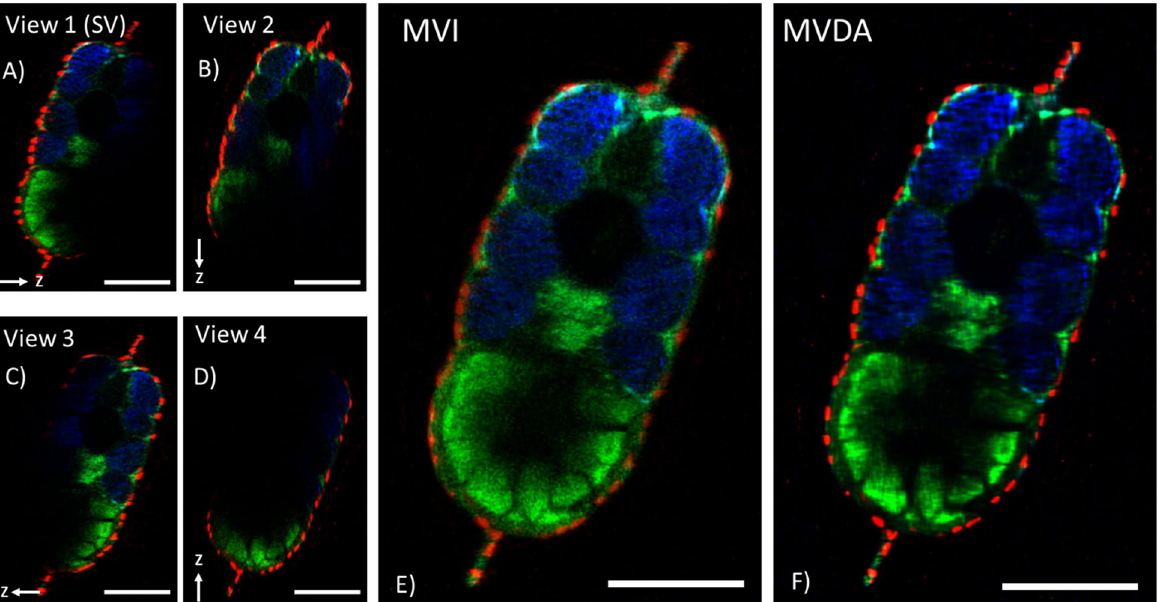
Figure 3. Cross section of the four view Multiview images of a 3dpf zebrafish sample. ( A – D ) Registered individual single view images. Arrow indicates the direction of the z axis of each view. Rotation axis for MVI was on the x-axis which is perpendicular to these images. ( E ) MVI (fusion) of single images, where the entirety of the sample is visible. ( F ) MV deconvolution approximation (MVDA) image. Structures appear with better contrast as noise is decreased and resolution improved. Low signal features become better visible in this image. Scale bars 100 μm. (Images were created with Fiji 26